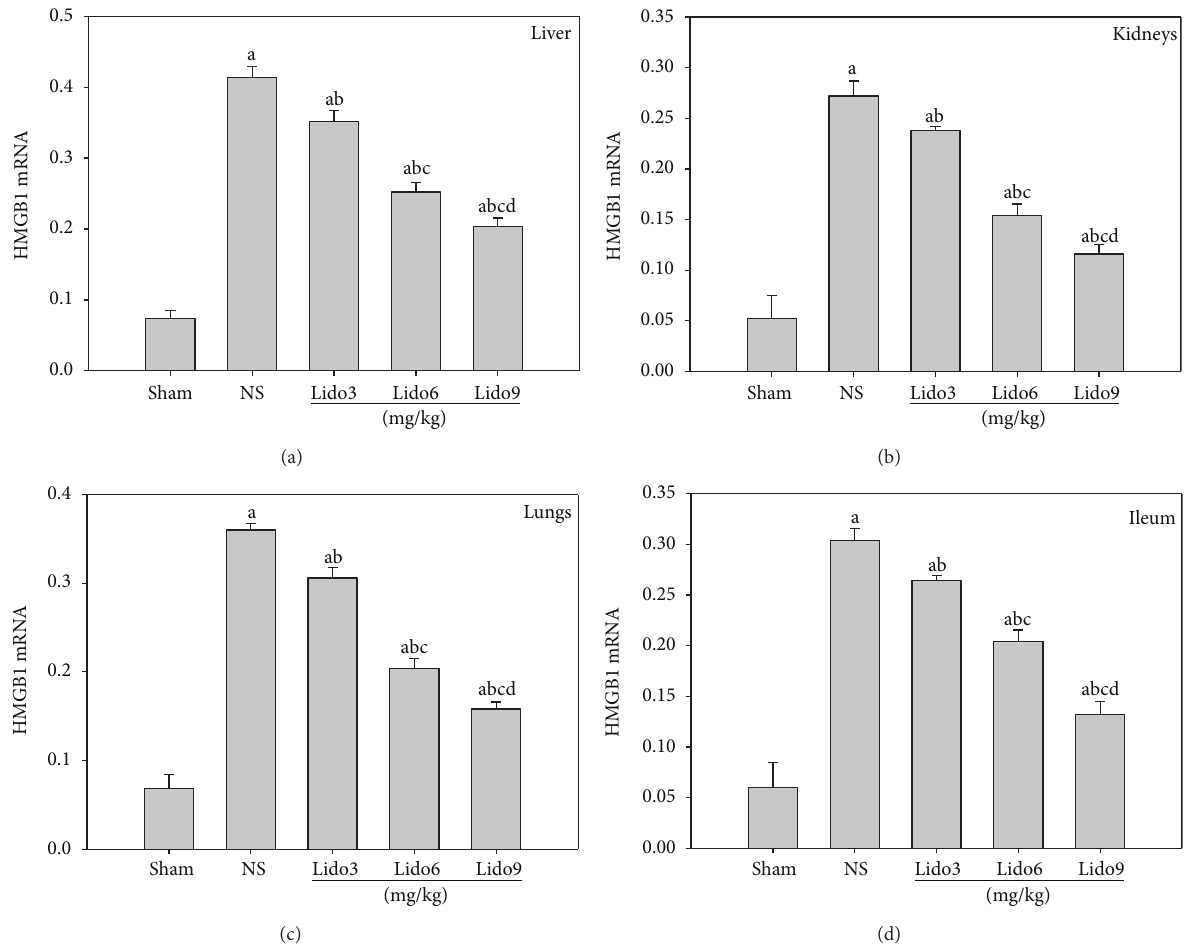
Figure 4: Lidocaine treatment inhibits HMGB1 mRNA expression in multiple organs of CLP-induced septic rats. Rats were treated with NS or lidocaine 10h after CLP. Liver, kidneys, lungs, and ileum were collected 24 h after CLP. HMGB1 mRNA expression in various organs were measured by Real-Time PCR. Data were presented as mean ± SD ( 𝑛 = 5 ). a 𝑃 < 0.001 versus Sham; b 𝑃 < 0.001 versus NS; c 𝑃 < 0.001 versus Lido3 mg/kg; d 𝑃 < 0.001 versus Lido6mg/kg; NS: normal saline; Lido: